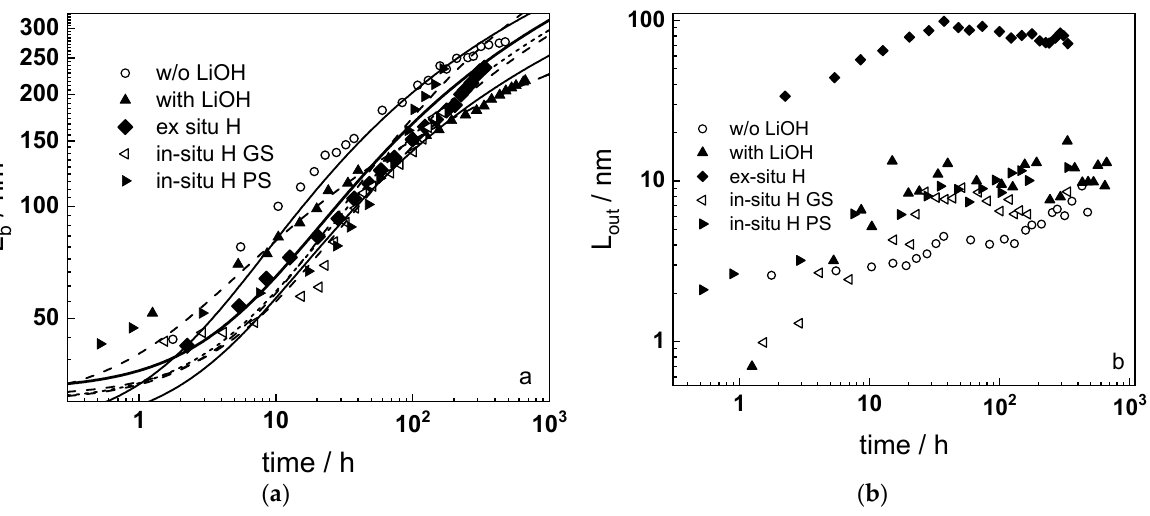
Figure 12. Thicknesses of the barrier oxide layer ( a ) and the outer layer ( b ) estimated from EIS depending on the oxidation time. Lines in ( a ) are best-fit calculations to Equation